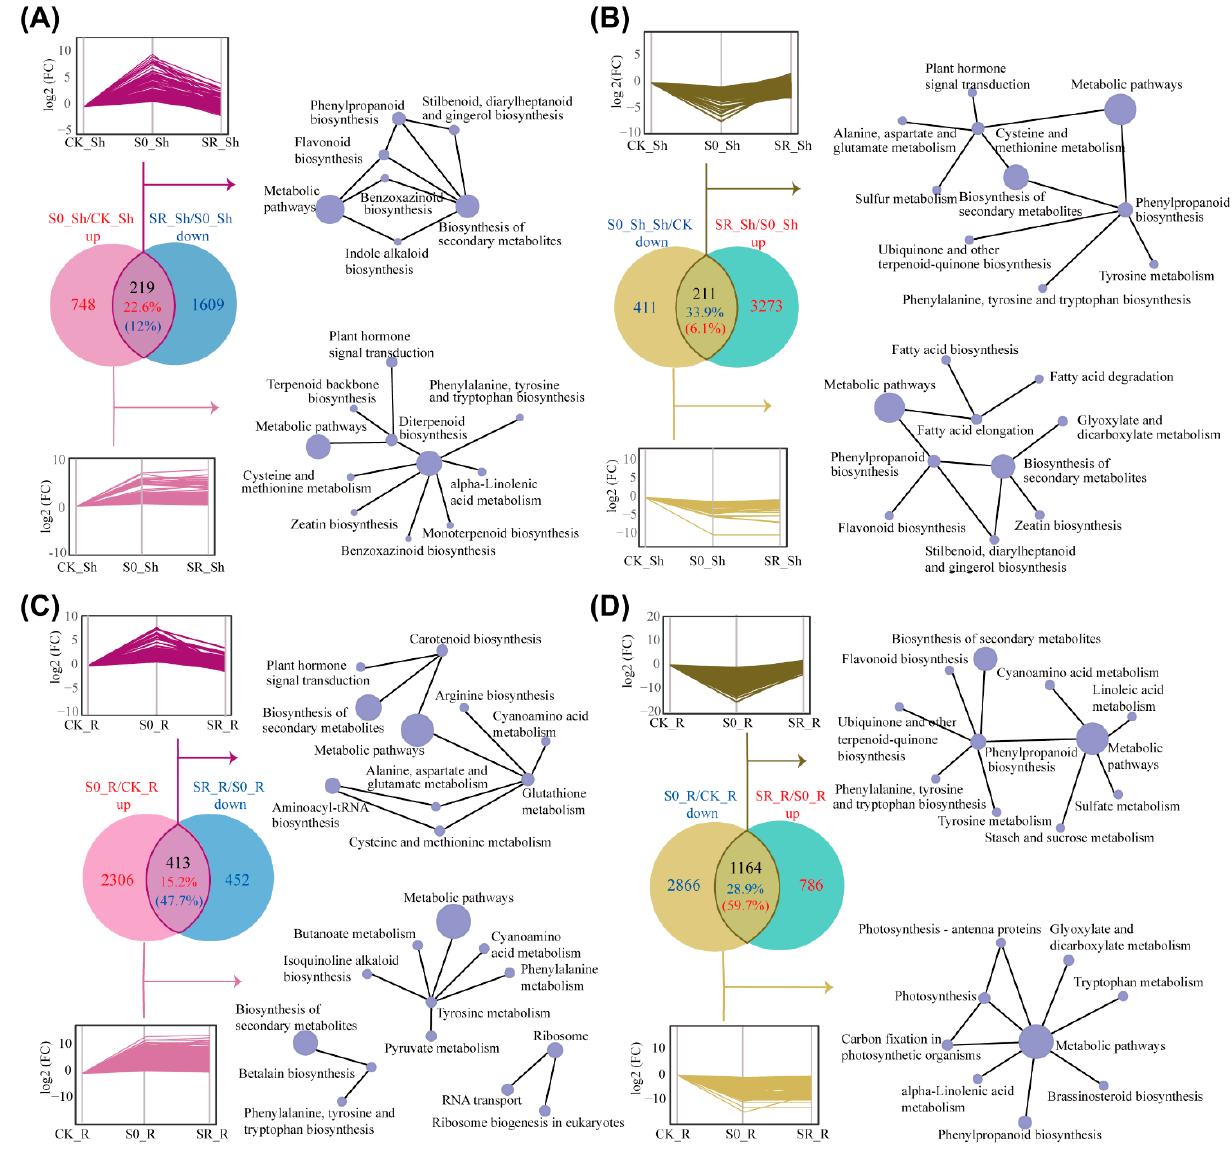
Figure 3. Transcriptomic response of S-deficient plants to sulfate resupply. ( A , B ) KEGG network analysis of up-regulated ( A ) or down-regulated DEGs ( B ) in response to sulfate resupply in shoots. ( C , D ) KEGG network analysis of up-regulated ( C ) or down-regulated DEGs ( D ) in response to sulfate resupply in roots. The number of DEGs with expression recovered after sulfate resupply were shown in Venn diagrams. The gene expression trend of DEGs with expressions recovered or unchanged in response to sulfate resupply was shown in upper and lower panels, respectively. The size of nodes in KEGG network represents the number of genes. CK, control; S0, S deficiency; SR, sulfate resupply; Sh, shoot; R, root; FC, fold change.